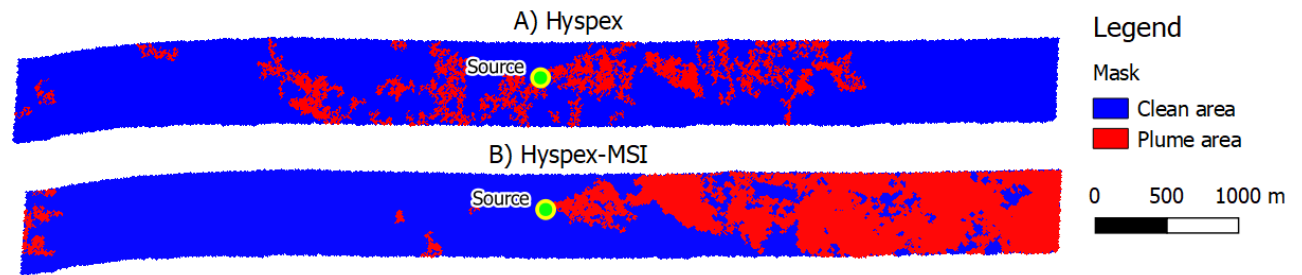
Figure 5. Plume mask estimated from ( A ) HYSPEX image and ( B ) HYSPEX + MSI. The green dot is the location of the source point.